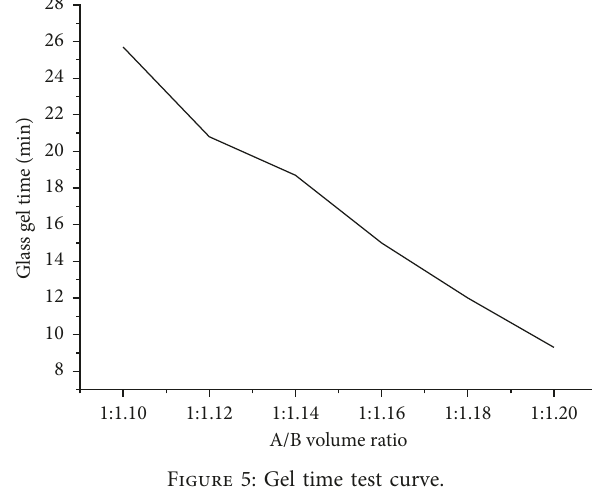
Figure 5: Gel time test curve.